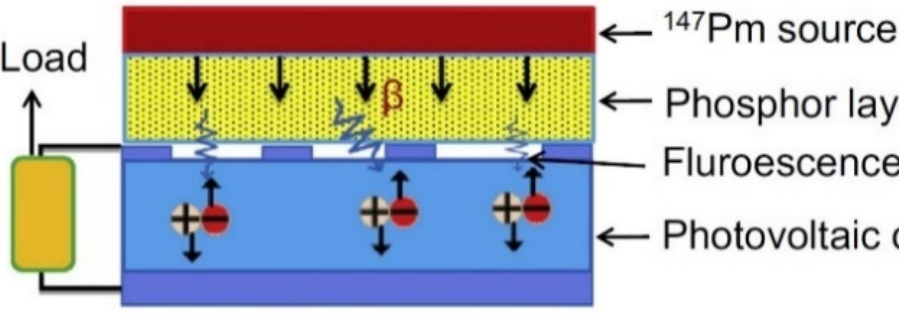
Figure 20. Schematic of a radioluminescent nuclear battery. Copyright permission from [153].